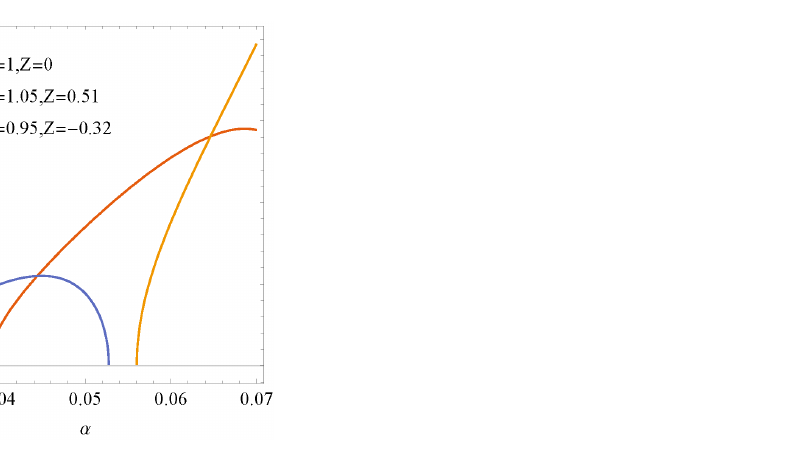
Figure 9. Nonlinear threshold finite wave amplitude in the supercritical stable region for various n and Z with α at Re = 10.